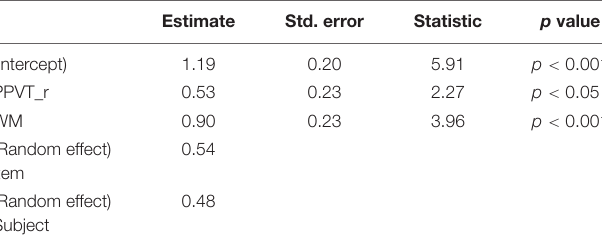
TABLE 7 | Regression results for individual differences in the CI TABLE 6 | Regression results for individual difference in the NH group. Std. error